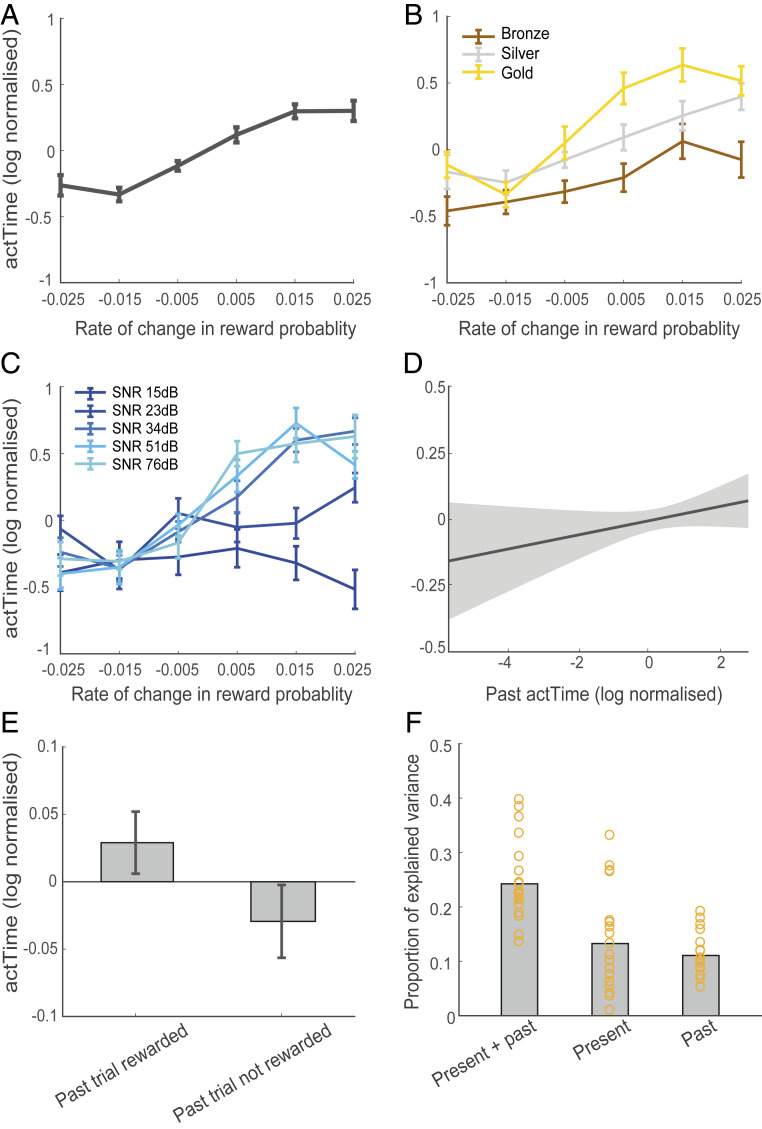
Present and past contextual factors influenced actTime. (A–C) Effect of present contextual factors on actTime. Participants waited before responding when bubbles were getting bigger (positive reward probability slope), but they acted quickly when bubbles were getting smaller (negative reward probability slope) (A) (see SI Appendix, Fig. S1, for individual participant data). The long actTime was more pronounced when participants were offered a large compared to a small reward (B) and when it was easy to track the rate of change in reward probability (low level of noise; SNR, signal-to-noise ratio) (C). On the x axis the rise is the difference between the reward probability in the last (0, 0.2, 0.4, 0.8, and 1) and first (0.5) bubble, and the run is the time it takes for the whole water tank to drain (20 s). (D and E) Effect of past contextual factors on actTime. Participants waited longer before responding when they had already delayed actTime on the past trial (D), and it was longer when they had received a reward compared to no reward on the past trial (E). Error bars show standard error of the mean across participants. In D, the shaded area is SE across observations. (F) Proportion of explained variance (PEV) in actTime explained by the Cox regression model. PEV is estimated separately from present and past, present, and past contextual factors. Each ring represents one participant. See also SI Appendix, Fig. S1.